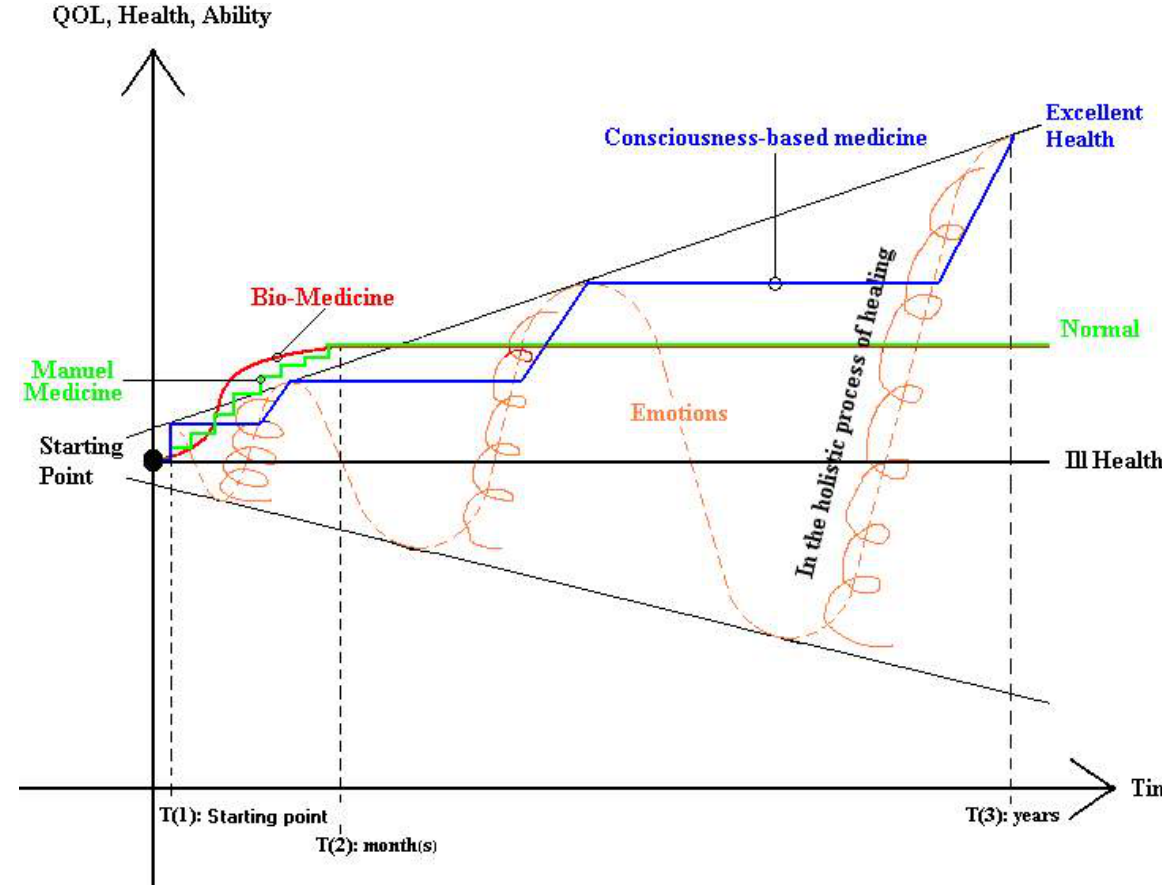
FIGURE 1. The common course of the healing process, within the three discussed paradigms. Where manual medicine often gives an immediate improvement of health, biomedicine takes a while, and holistic medicine has phases of holistic healing (often hours, marked coiled), phases of recreation (weeks to months), and prolonged phases of learning and personal growth (typically years). Manual medicine takes care of the body here and now. Biomedicine takes care of biochemical and physiological disturbances, often of long duration, if the disease is not cured but becomes chronic. Holistic medicine engages the patient in a process of existential healing and personal growth, often for